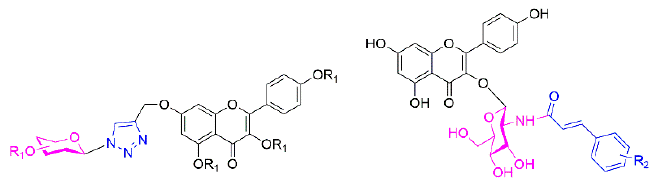
Figure 1. General molecular formulas of two series of flavonoid derivatives.